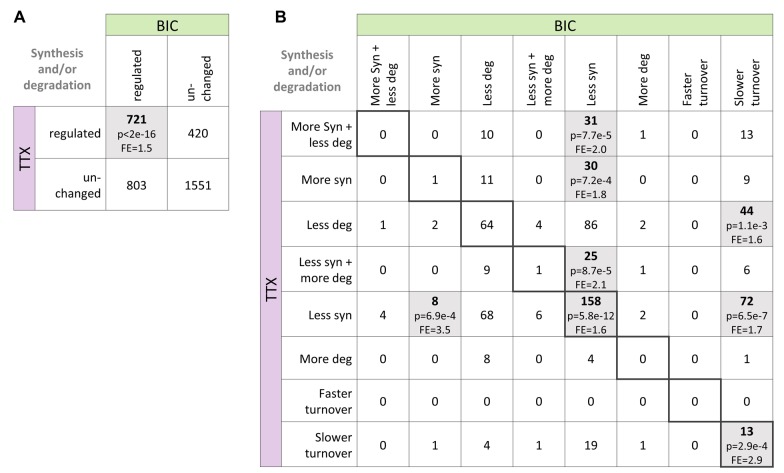
Comparison of changes in protein synthesis and/or degradation during homeostatic up- and down-scaling.(A) Numbers of proteins with significant changes in protein synthesis and/or degradation during BIC-induced down-scaling and TTX-induced up-scaling. Significantly more proteins were affected by both treatments than expected by chance (Fisher’s exact test). P-value and fold-enrichment (FE) are indicated. (B) Detailed comparison of changes in protein synthesis and/or degradation. Significantly over-represented combinations are highlighted, and p-values and fold-enrichment (FE) are indicated.